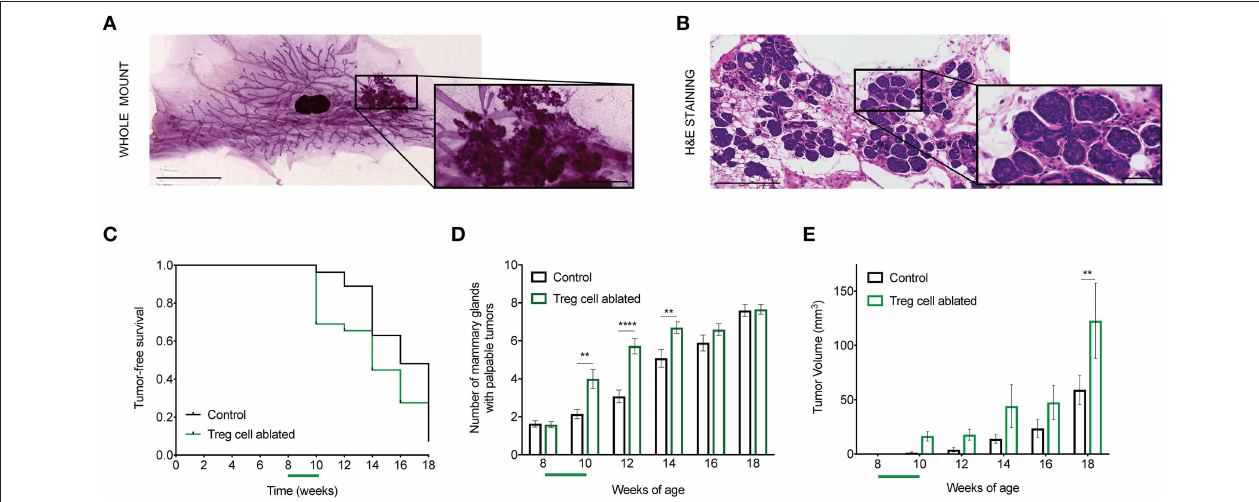
FIGURE 1 | Treg cell ablation accelerates primary tumor growth. (A,B) Representative mammary gland whole mount (A) and section stained with H&E (B) from 8-week-old MMTV-PyMT mouse. Amplified region depicts tumor area (A) and hyperplasia/adenoma pre-invasive stage (B) , respectively. Scale bars represent 5mm and 1mm (lower and higher magnification, respectively; whole mount) as well as 250 and 50 µ m (lower and higher magnification, respectively; H&E stain). (C) Tumor-free survival curve (D) , number of mammary glands with palpable tumors, and (E) tumor growth kinetics in Treg cell-ablated mice compared with control mice ( n = 30–33 mice). ** p = 0.006; **** p < 0.0001 (D) and ** p = 0.0075 (E) . Values are expressed as mean ± SEM and p-values were calculated using two-way ANOVA, followed by Bonferroni’s post-hoc test. Green bar on the x axis indicates period of Treg cell ablation. Data were pooled from two independent experiments.